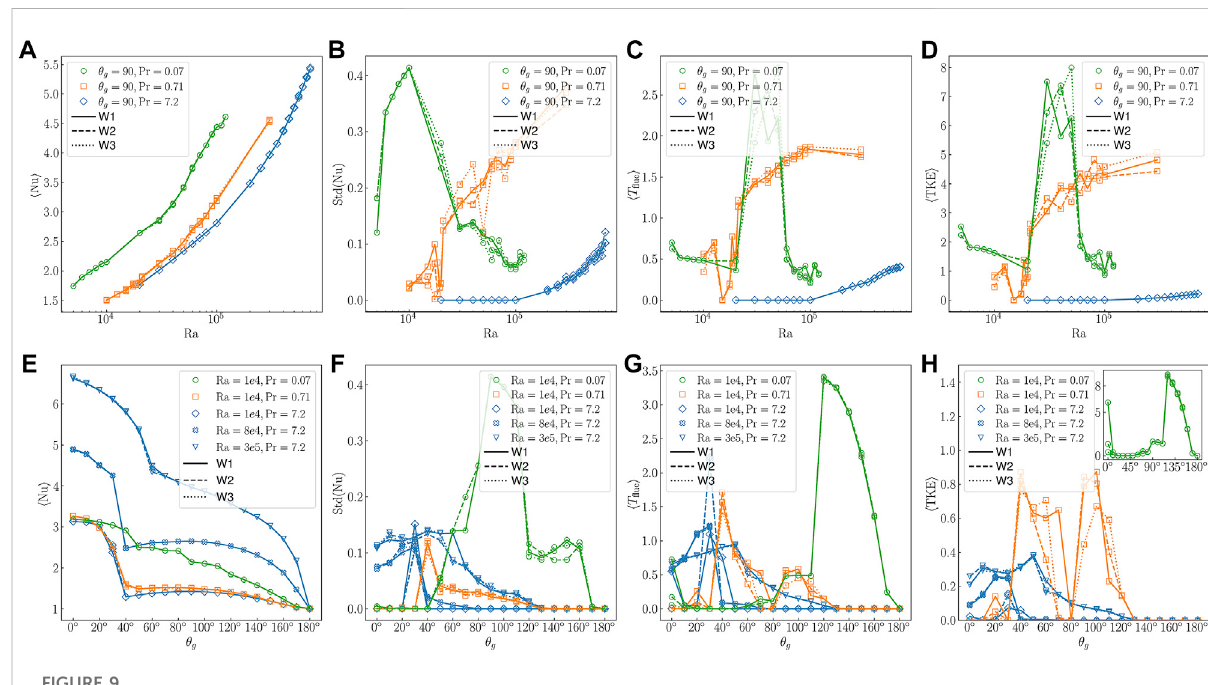
FIGURE 9 Parametric variabilityin theFOM: green – Pr = 0.07, orange – Pr = 0.71,and blue – Pr = 7.2. Each plotreveals absence/presence of chaotic effects bypresentingstatisticstakenoverthreetimewindows,W1,W2,andW3. (A – D) : Ra -dependenceofmeanNu,Std(Nu),meantemperature fl uctuation, and mean TKE computed over time windows W1, W2 and W3. (E – H) : θ g -dependence at fi xed